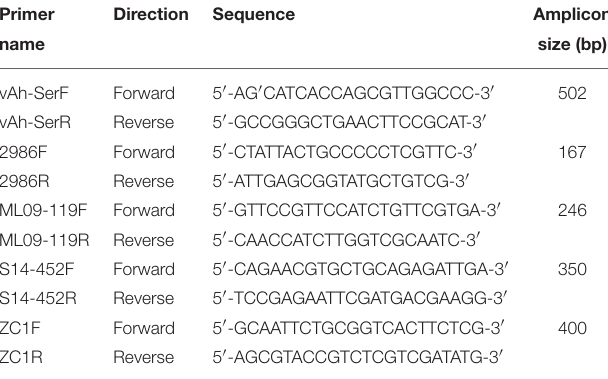
TABLE 2 | Oligonucleotide primers specific to members of the vAh pathotype (vAh-SerF and vAh-SerR), previously described qPCR vAh primers (2986F and 2986R), and primers used to screen for unique isolates used in this study (ML09-119F, ML09-119R, S14-452F, S14-452R, ZC1F, and